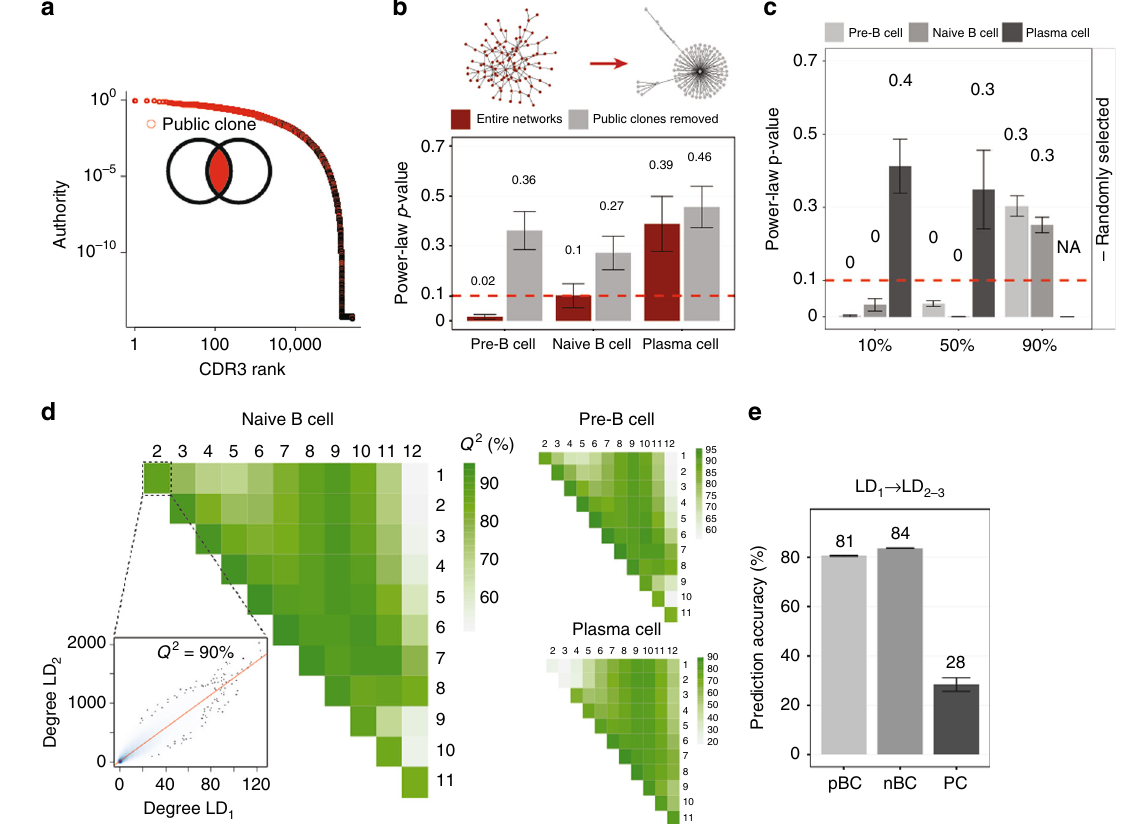
Fig. 3 The architecture of antibody repertoires is robust and redundant. a CDR3 clones of an exemplary naïve B-cell repertoire (OVA-immunized mouse) have been ordered from increasing to decreasing frequency (CDR3 rank). Public clones are color-coded in red. b Bootstrapped p -values of the power-law fi t are shown for complete antibody repertoires and after removing public clones. Power law is a good fi t to degree distributions for p-values above the dashed red line ( p -value = 0.1, Wilcoxon test). Examples of exponential (red) and power-law (gray) networks are shown on the top panel. c CDR3 clones were removed randomly at 10%, 50%, and 90% from each original repertoire (20 times) and the power-law distribution was fi t to the cumulative degree distributions of the remaining CDR3 clones. A p -value = 0.1 (Wilcoxon test) is indicated as a red dashed line. In PC samples a fi t was not feasible after removal of 90% of CDR3 clones (NA). d Heatmaps indicate the mean prediction accuracy ( Q 2 , leave-one-out cross-validated R 2 ) of similarity layer LD 1 versus similarity layers LD 2 – 12 . The scatterplot shows Q 2 for LD 1 vs. LD 2 for each CDR3 clone. e Prediction accuracy ( Q 2 ) for LD 1 vs. LD 2 and LD 3 . For b, c, e, barplots show mean ± s.e.m. Source data are provided as a Source Data fi